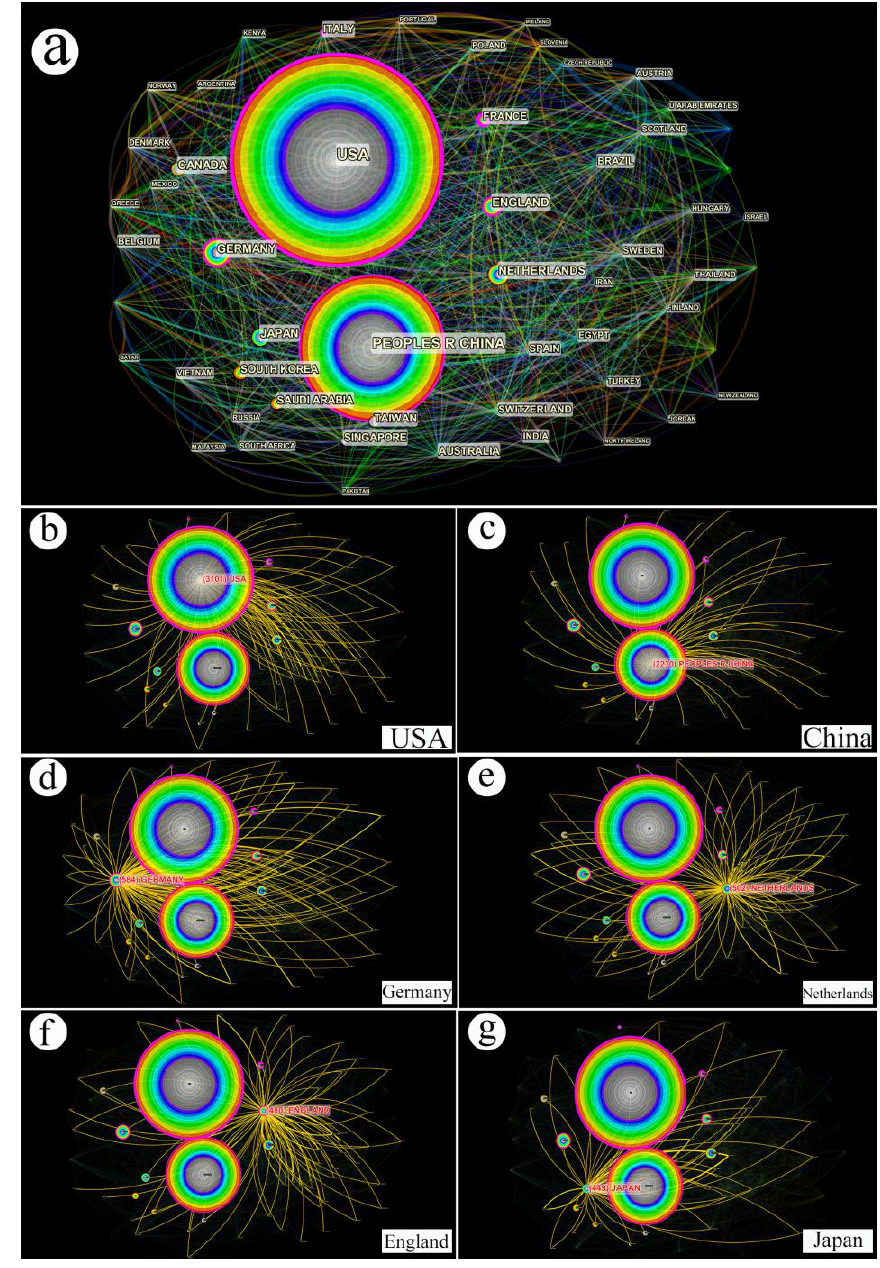
Figure 3. The visualization of international collaboration and internal links on coronavirus research. ( a ) The comprehensive international collaboration network; ( b ) internal links of the USA with other regions involved in 3101 articles; ( c ) internal links of China with other regions involved in 2230 articles; ( d ) internal links of Germany with other regions involved in 584 articles; ( e ) internal links of Netherlands with other regions involved in 502 articles; ( f ) internal links of England with other regions involved in 480 articles; ( g ) internal links of Japan with other regions involved in 449 articles.